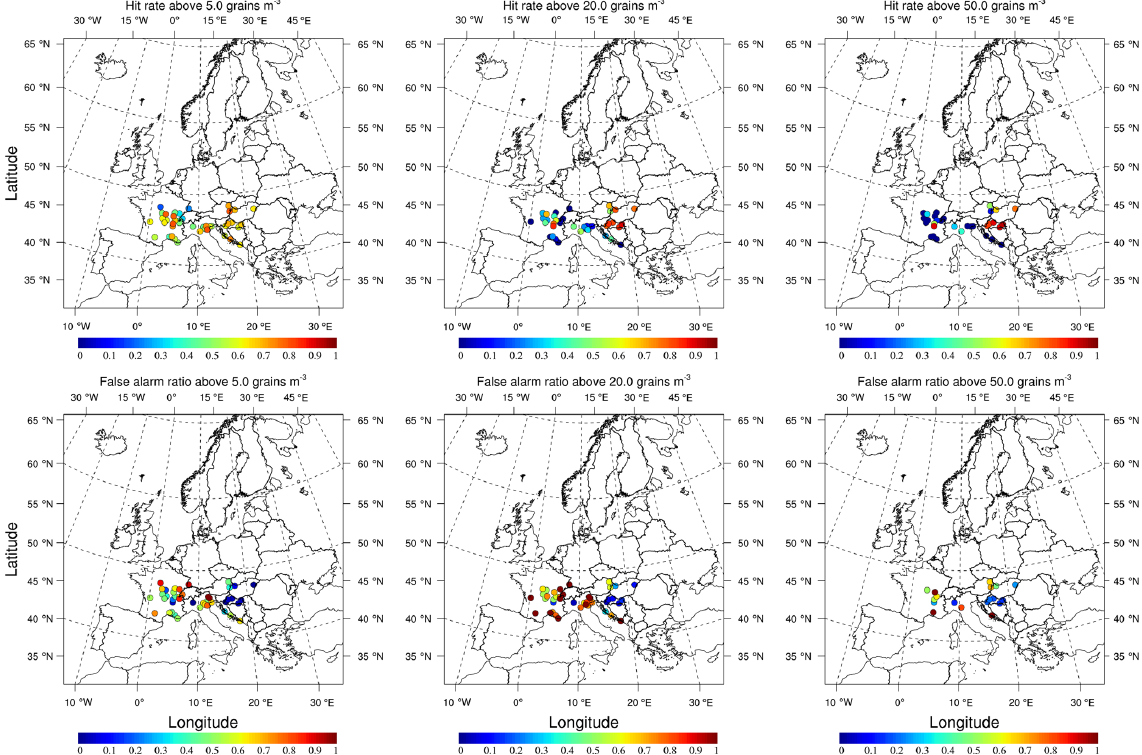
Figure 8. Categorical statistics at thresholds of 5 (left column), 20 (middle column), and 50 grainsm − 3 (right column): upper panel – hit rate (percentage of correctly predicted exceedances to all actual exceedances), lower panel – false alarm ratio (percentage of incorrectly predicted exceedances to all predicted